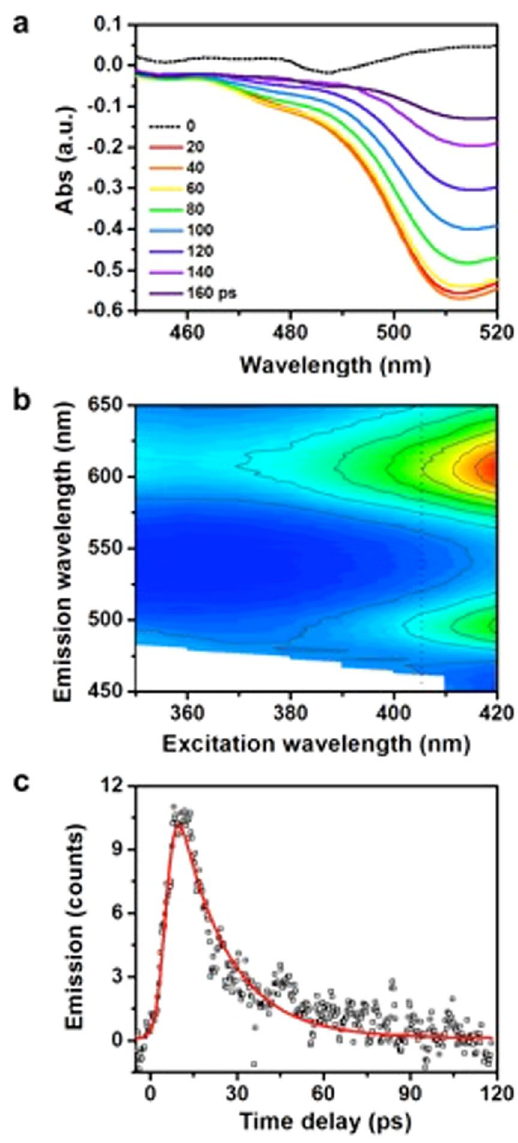
Figure 6. Photoluminescence signal emanated from Ag NPs regenerating layer. ( a ) Steady-state photoluminescence emanated from the complete system during photocatalysis. ( b ) Steady-state fluorescence profile of betanin in water (10 ppm AcOEt) at pH = 12. ( c ) Kinetic trace extracted at 515 nm with streak camera time-resolved fluorescence upon excitation at 390 nm of Bts-Ag NPs_pABA_TiO 2 :Ru NPs in aqueous